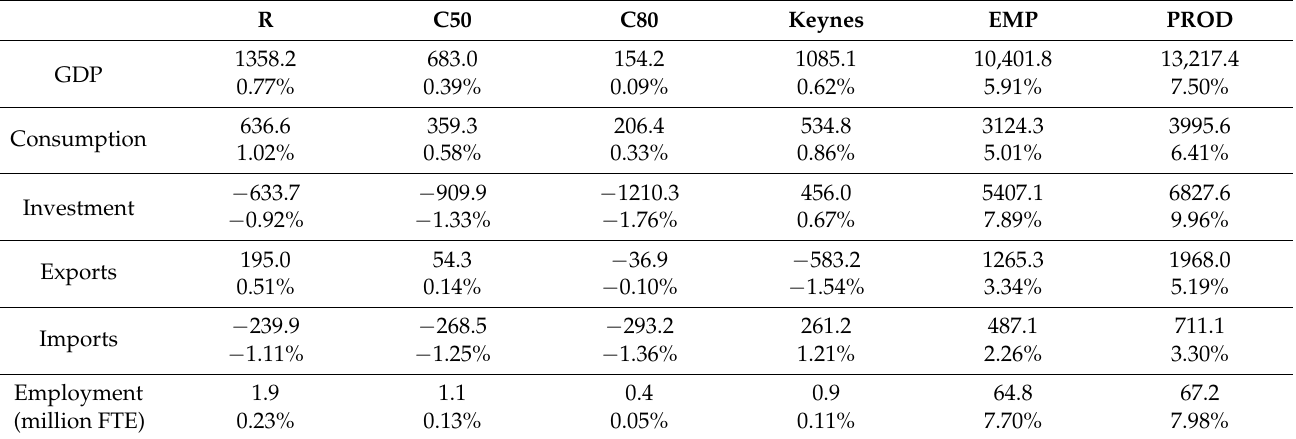
Table 3. Macroeconomic Impacts in China (change from 2030 BAU in real billion RMB and percent- age).